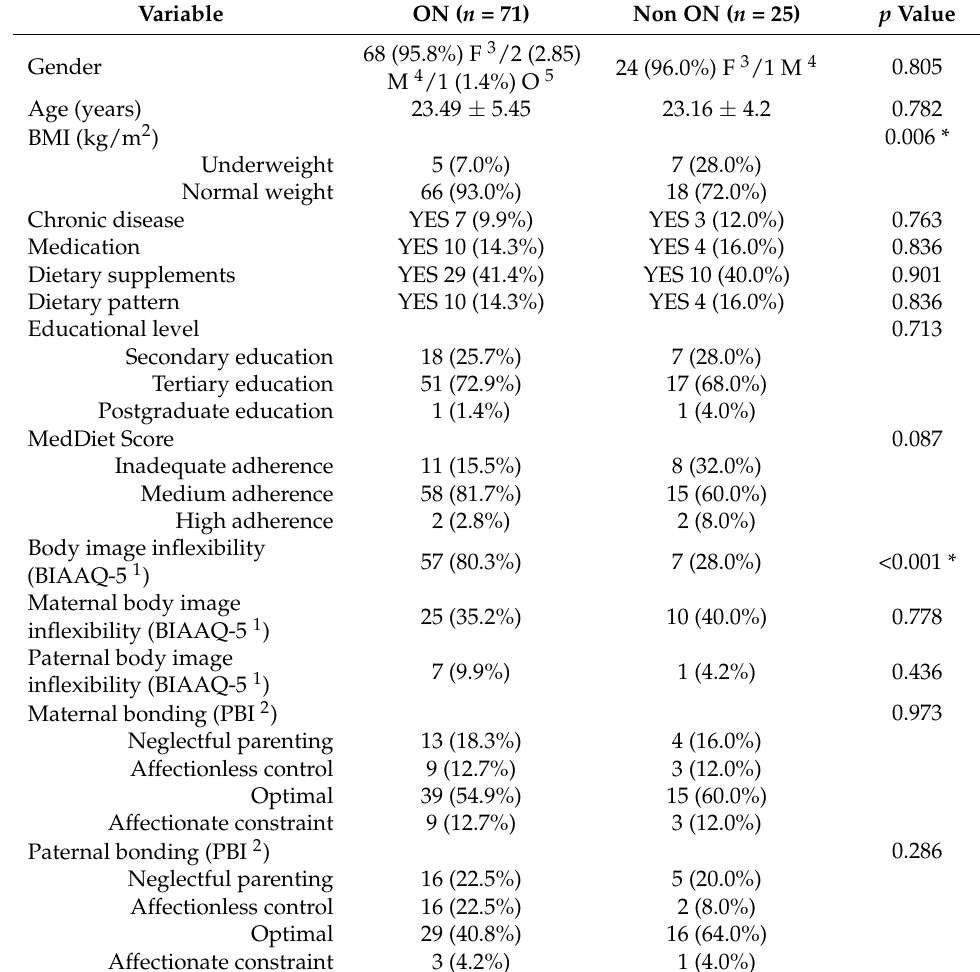
Table 1. Characteristics of professional dancers ( n = 96), according to classification into orthorexia nervosa (ON), and non-orthorexia nervosa (non ON), based on scores in the ORTHO-15 questionnaire.